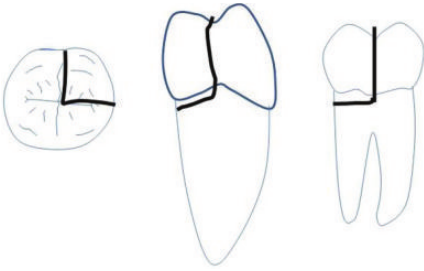
Figure 8: Extent of fracture line in 37.